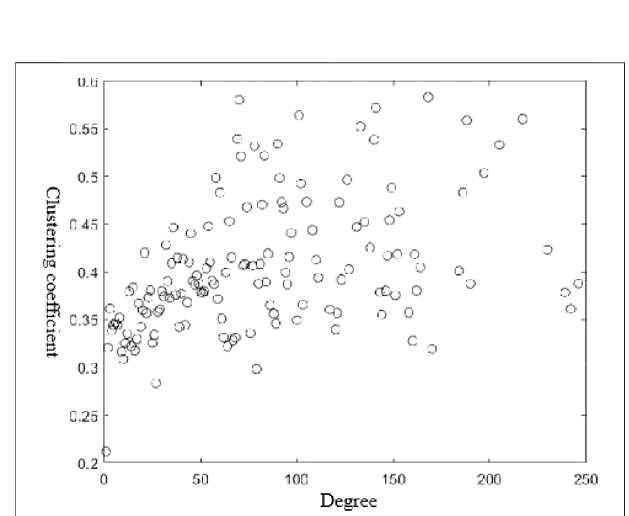
FIGURE 7 | Relationship between the clustering coef fi cient and the degree of the node in the global aviation network.